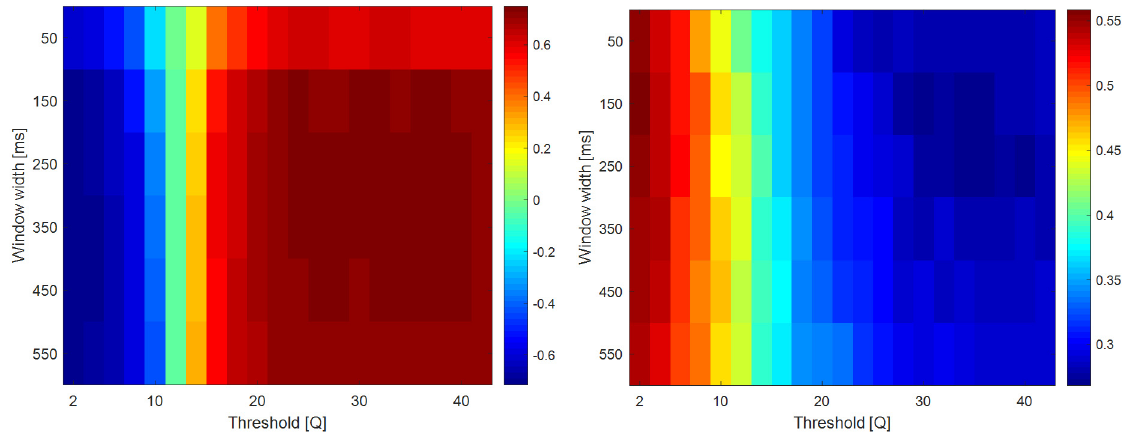
of MAV at rest) and window widths (actual value of Q is shown/10).